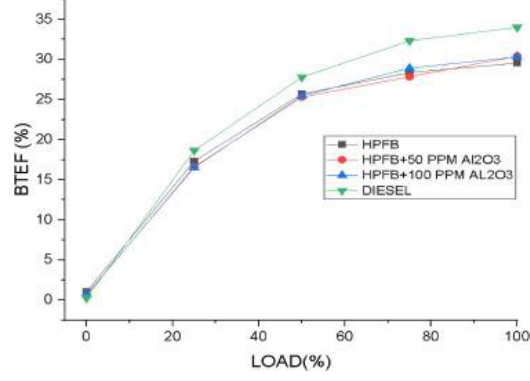
Fig. 8. Effect of the additive on thermal efficiency of braking